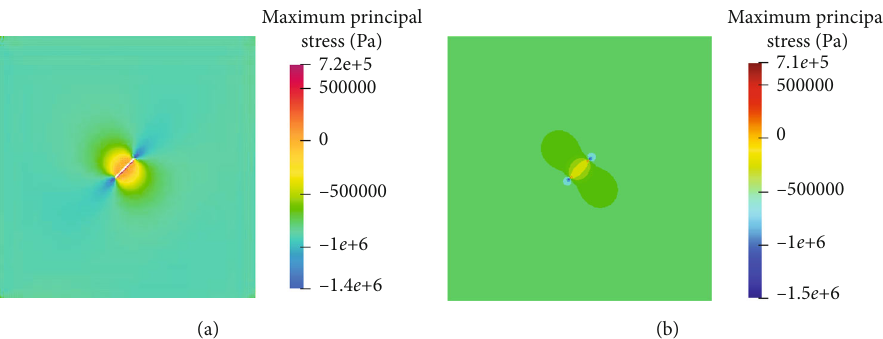
Figure 6: Maximum principal stress distributions calculated by two methods. (a) IKSPH results. (b) Abaqus results.